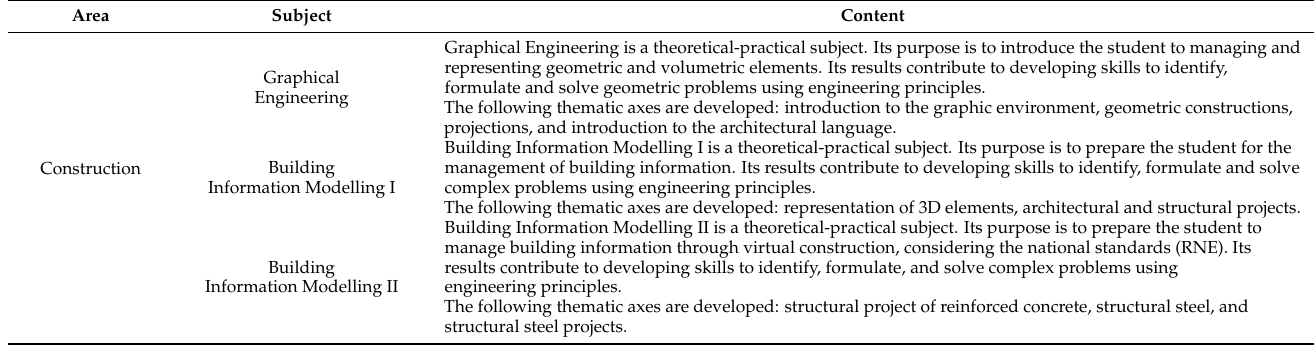
Table 9. BIM-related training areas, subjects, and contents from the civil engineering